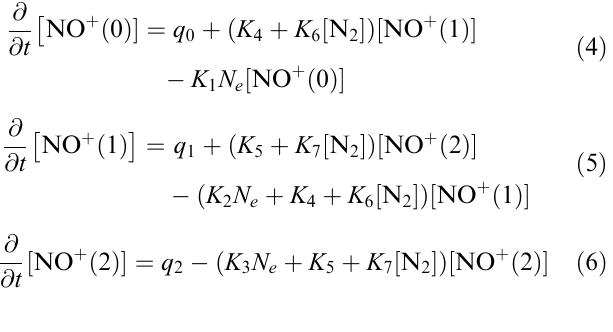
Table 1. Modeled root mean square errors of hmF2 and